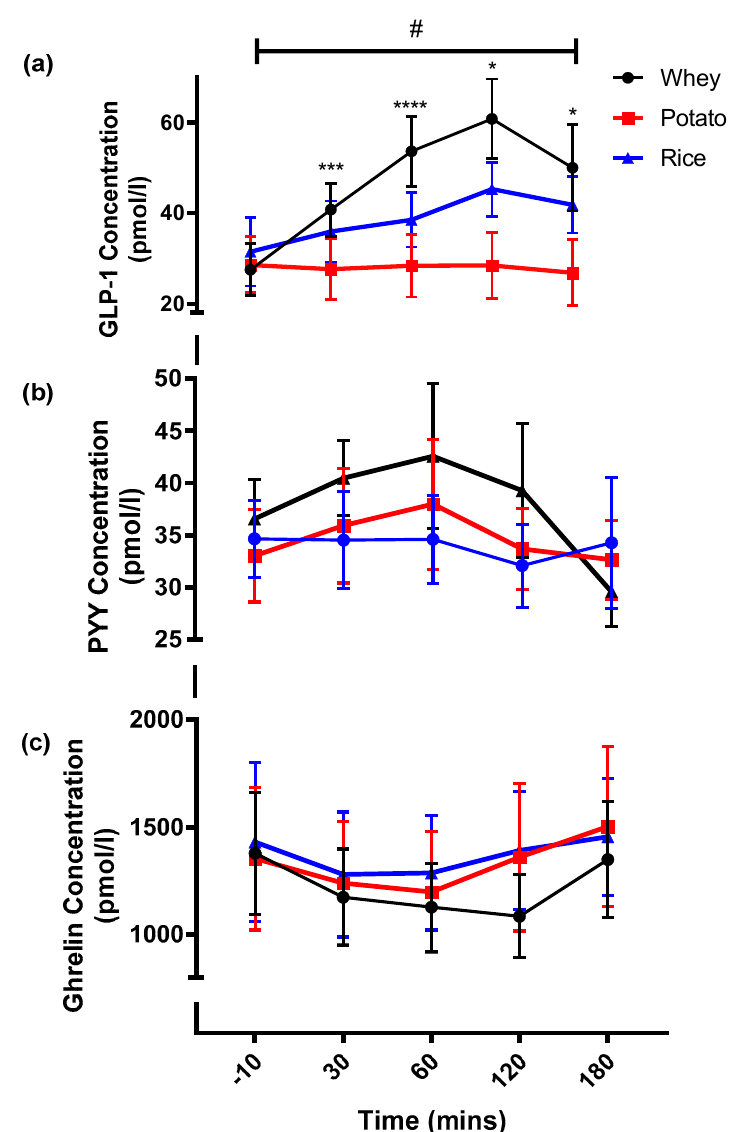
Figure 3. ( a ) Blood GLP-1 concentrations, ( b ) Blood PYY concentrations and ( c ) Blood ghrelin concentrations observed across the three experimental conditions. * Potato is significantly different to both conditions ( p < 0.05). *** Whey is significantly different from potato only ( p < 0.05). **** All conditions significantly different to each other ( p < 0.05). # Shows that significance was present with time ( p < 0.05).